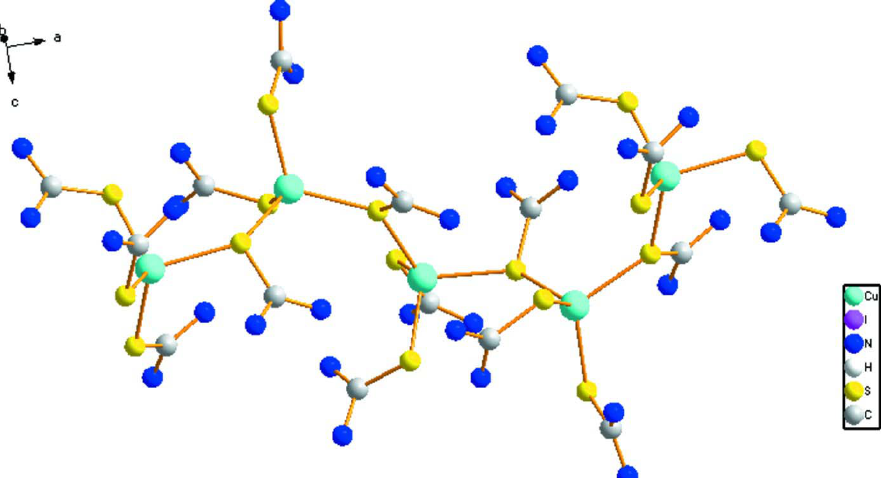
Figure 1 The asymmetric unit with atom labels and 30% probability displacement ellipsoids. H atoms are not shown.